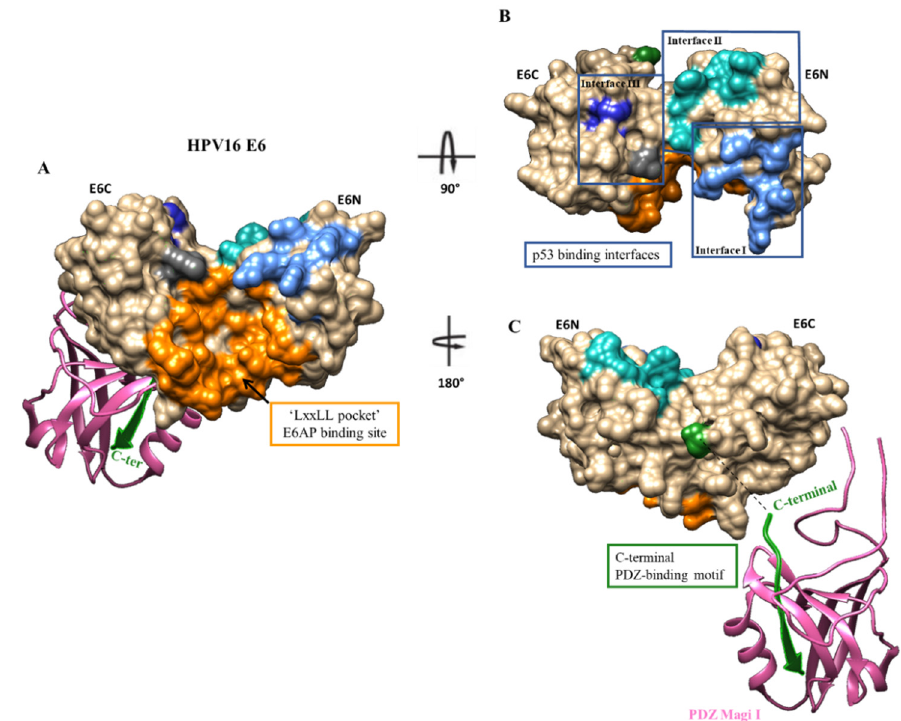
Figure 1. A map of different binding sites of the HPV16 E6 protein using PDB ID 4XR8 and 2KPL on Chimera software. Surface representation of E6 residues that participate in the binding with E6AP ( A ), p53 ( B ), and the PDZ domain ( C ). A —Orange residues participate in E6AP binding; B —The three interfaces of contact between E6 and p53 are colored in light, medium, and dark blue. C —The C-terminal PDZ binding motif is represented in green. E6N: N-terminal; E6C: C-terminal.